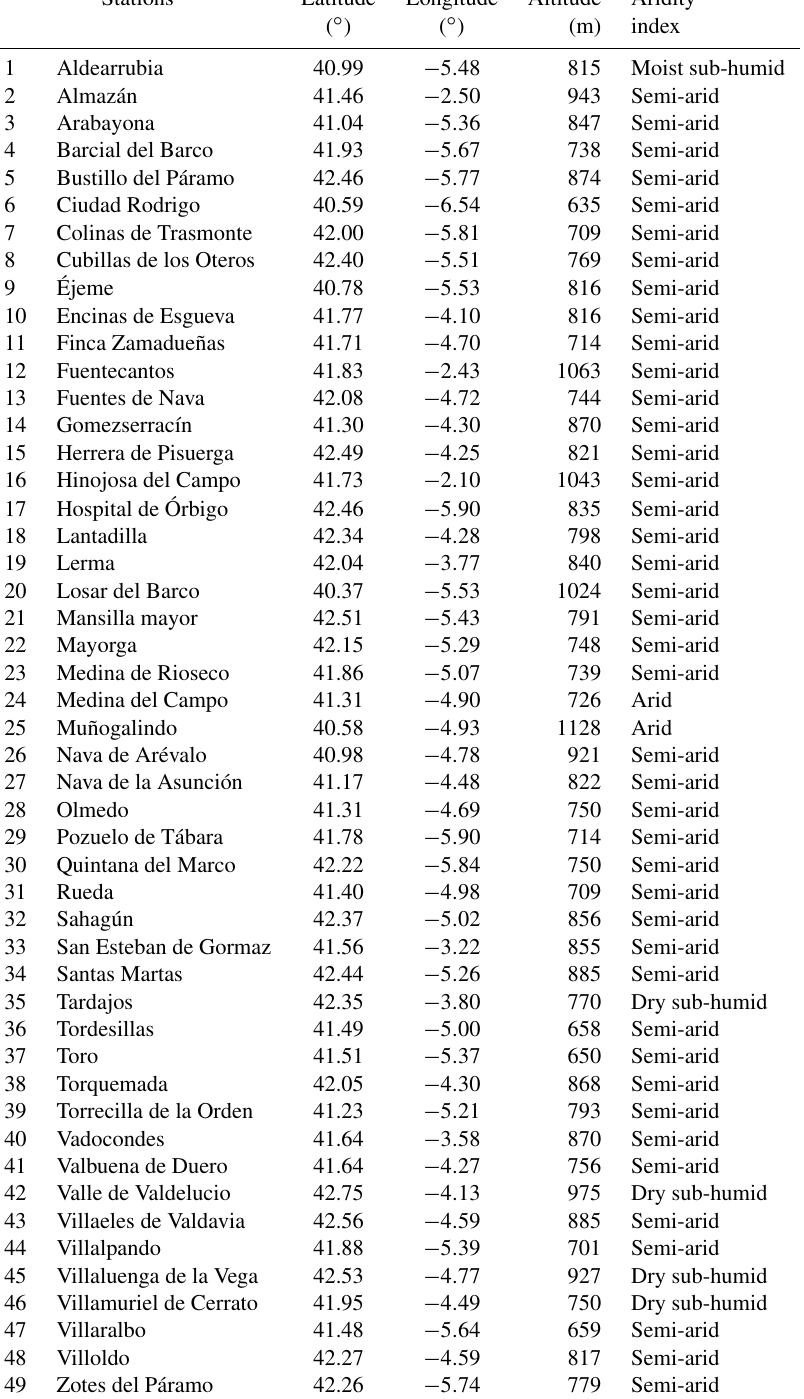
Table 1. Agrometeorological station used in the study. Coordinates and aridity index are